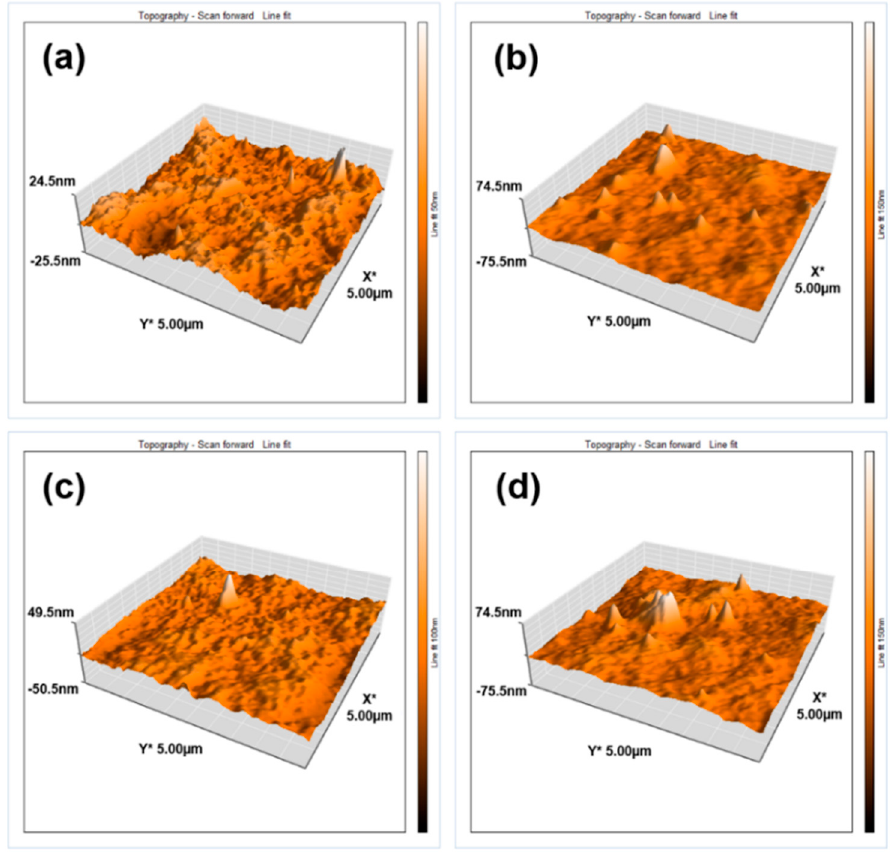
Figure 7. AFM 3D roughness for membranes with: ( a ) 0.1 wt.% TiO 2 Rutile, ( b ) 1 wt.% TiO 2 Rutile, ( c ) 0.1 wt.% TiO 2 Anatase, ( d ) 1 wt.% TiO 2 Anatase.